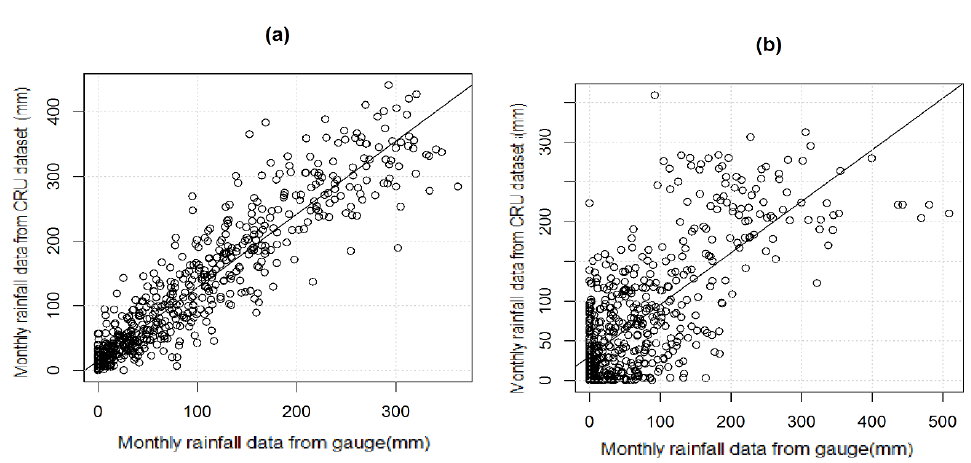
Key: D n is test statistic computed at a probability level of p .